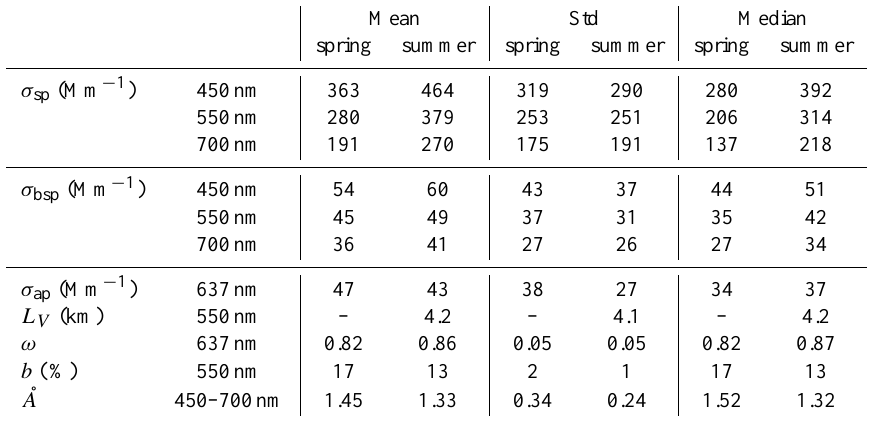
Table 1. Statistic values of aerosol optical properties measured at dry condition. (4321 data points for spring campaign and 4897 data points for summer campaign). Mean Std Median spring summer spring summer spring summer σ sp (Mm − 1 ) 450nm 363 464 319